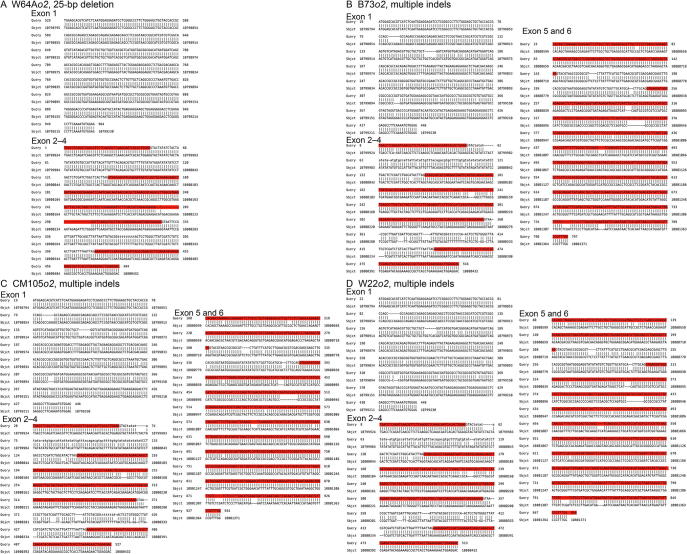
The o2 alleles in W64Ao2 (A), B73o2 (B), CM105o2 (C), and W22o2 (D) mutants Exons are highlighted in red. “Query” refers to the sequences of o2 alleles, and “Sbjct” refers to the sequence corresponding to o2 alleles in the maize reference genome (RefGen_v3.25), based on the BLAST results.